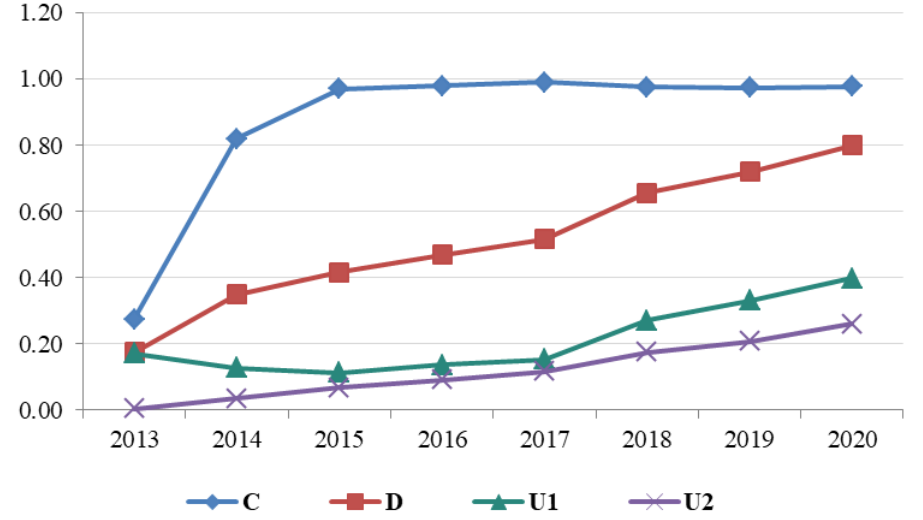
Figure 5. Coupling coordination type of the LI and DE in Anhui Province.